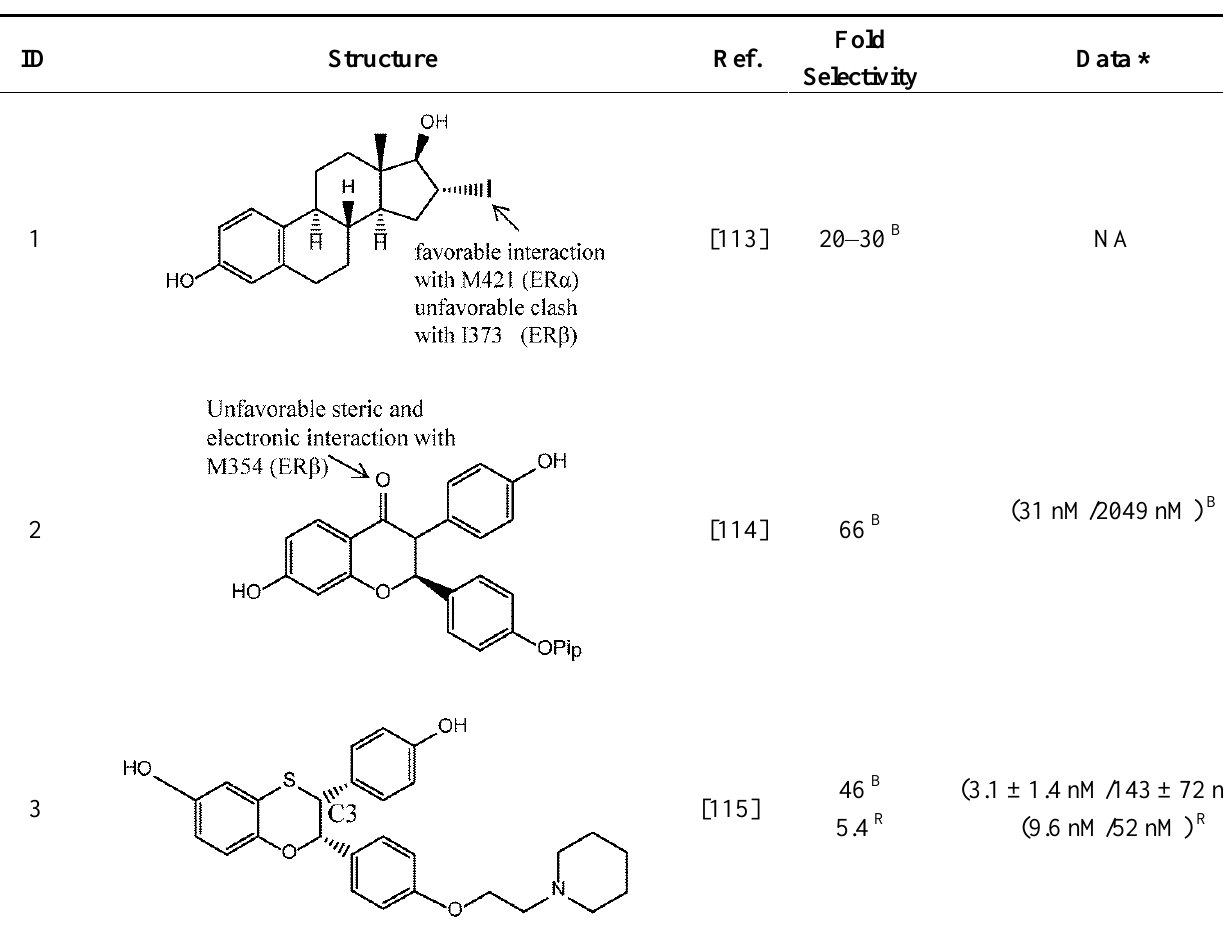
Table 3. ERα selective compounds with their respective fold selectivity for ERα. * Data for assays performed: the first number indicates data for ERα and the second number indicates data for ERβ; In superscript, B indicates binding assays, R indicates HEK 293 reporter gene assays. NA indicates that binding data was not reported. ID indicates the compound number that is cited in the